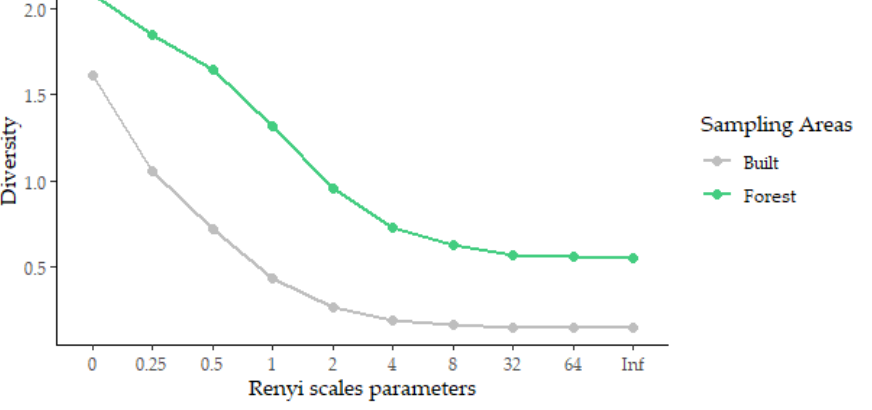
Figure 3. Rényi diversity profile of sand flies collected in the forest and urban areas from May 2019 of Paraíba, Brazil. Table 4. Spearman’s correlation results between the most frequent species in the forest areas and built areas with environmental conditions, of Jo ã o Pessoa, Para í ba,